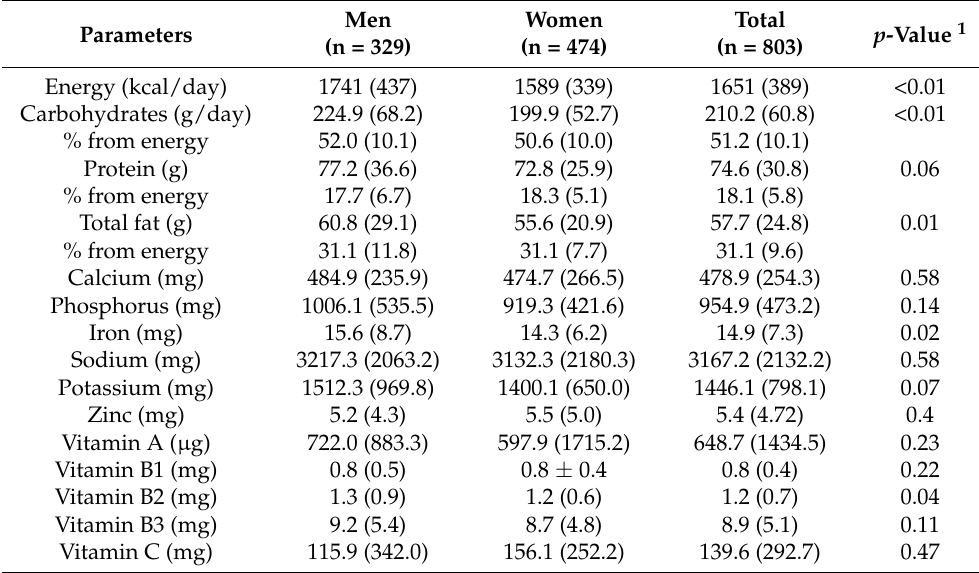
Table 2. Nutrient intake of the subjects from the development phase (n =